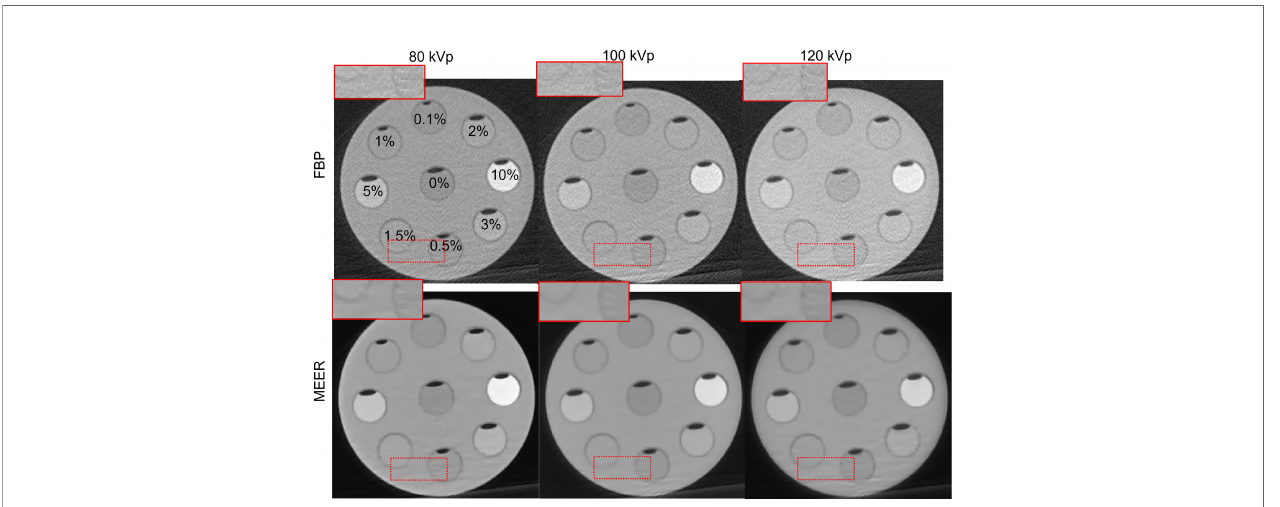
FIGURE 5 | Reconstructed CT images in experimental study. Dashed rectangles indicate zoomed in view regions. The CT images are displayed at a window of [-500, 500]